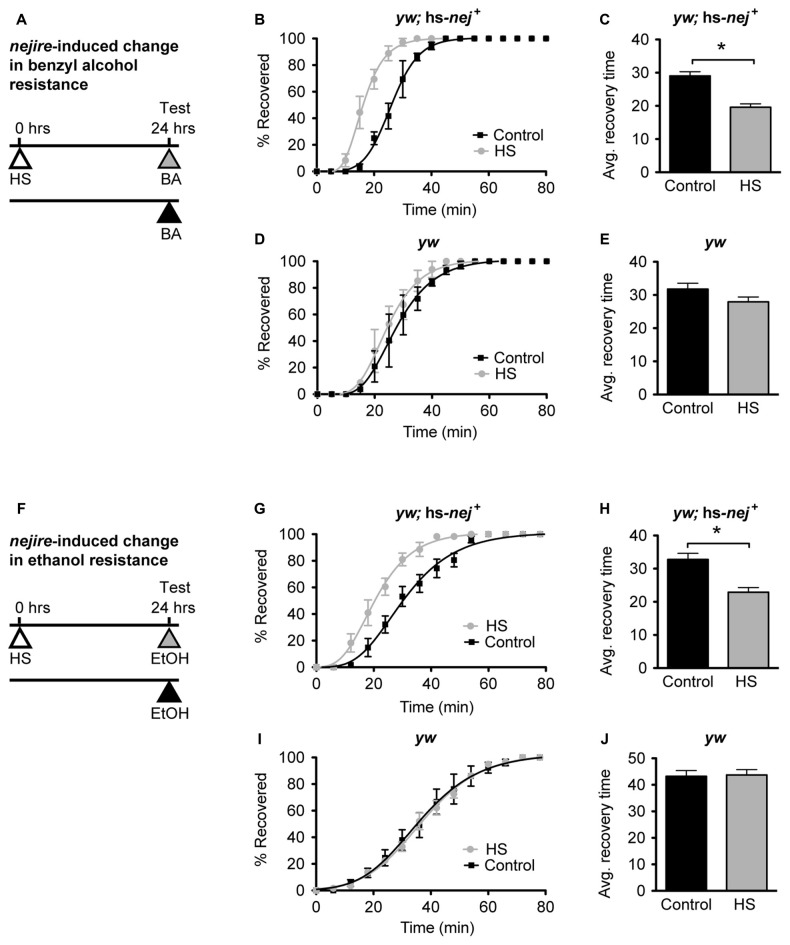
nejire induction produces alcohol resistance. (A,F) Schematic depiction of the 2-day treatment protocol. A heat-shock (HS) inducible transgenic construct in which the Hsp70 promoter drives expression of a nejire cDNA was used to drive expression of CBP, 24 h prior to sedation with either benzyl alcohol (top, A–E) or ethanol (bottom, F–J). (B,C) Recovery curves (B) and average-recovery time (C) from benzyl alcohol sedation of transgenic yw; hs-nej + flies in which CBP was induced (HS) or uninduced (Control). Error bars represent SEM (Student’s t-test: *denotes P < 0.0001, n = 52 [Control], 54 [HS]). (D,E) Recovery curves (D) and average-recovery time (E) from benzyl alcohol sedation of control yw flies lacking the hs-nej + transgene in which a HS or control treatment (Control) was applied. Error bars represent SEM (Student’s t-test: not significant). (G,H) Recovery curves (G) and average-recovery time (H) from ethanol sedation of transgenic yw; hs-nej + flies in which CBP was induced (HS) or uninduced (Control). Error bars represent SEM (Student’s t-test: *denotes P < 0.0001, n = 36 [Control], 36 [HS]). (I,J) Recovery curves (I) and average-recovery time (J) from ethanol sedation of control yw flies lacking the hs-nej + transgene in which a HS or control treatment (Control) was applied. Error bars represent SEM (Student’s t-test: not significant).